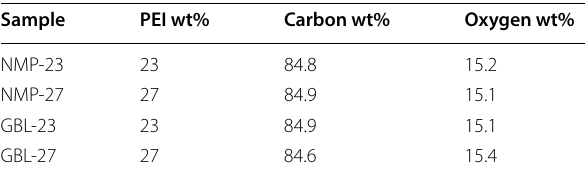
Table 6 EDX data for PEI membranes prepared from NMP and GBL